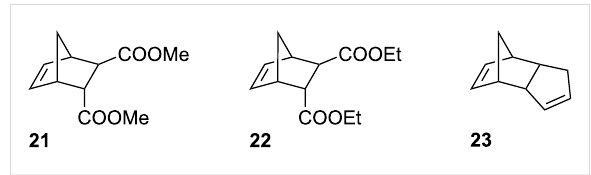
Figure 7: Monomers utilized in model ROMP